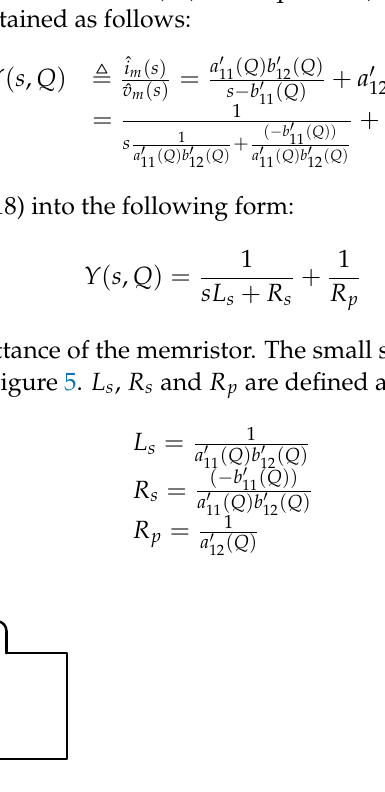
Figure 5. Small signal equivalent circuit of the memristor.